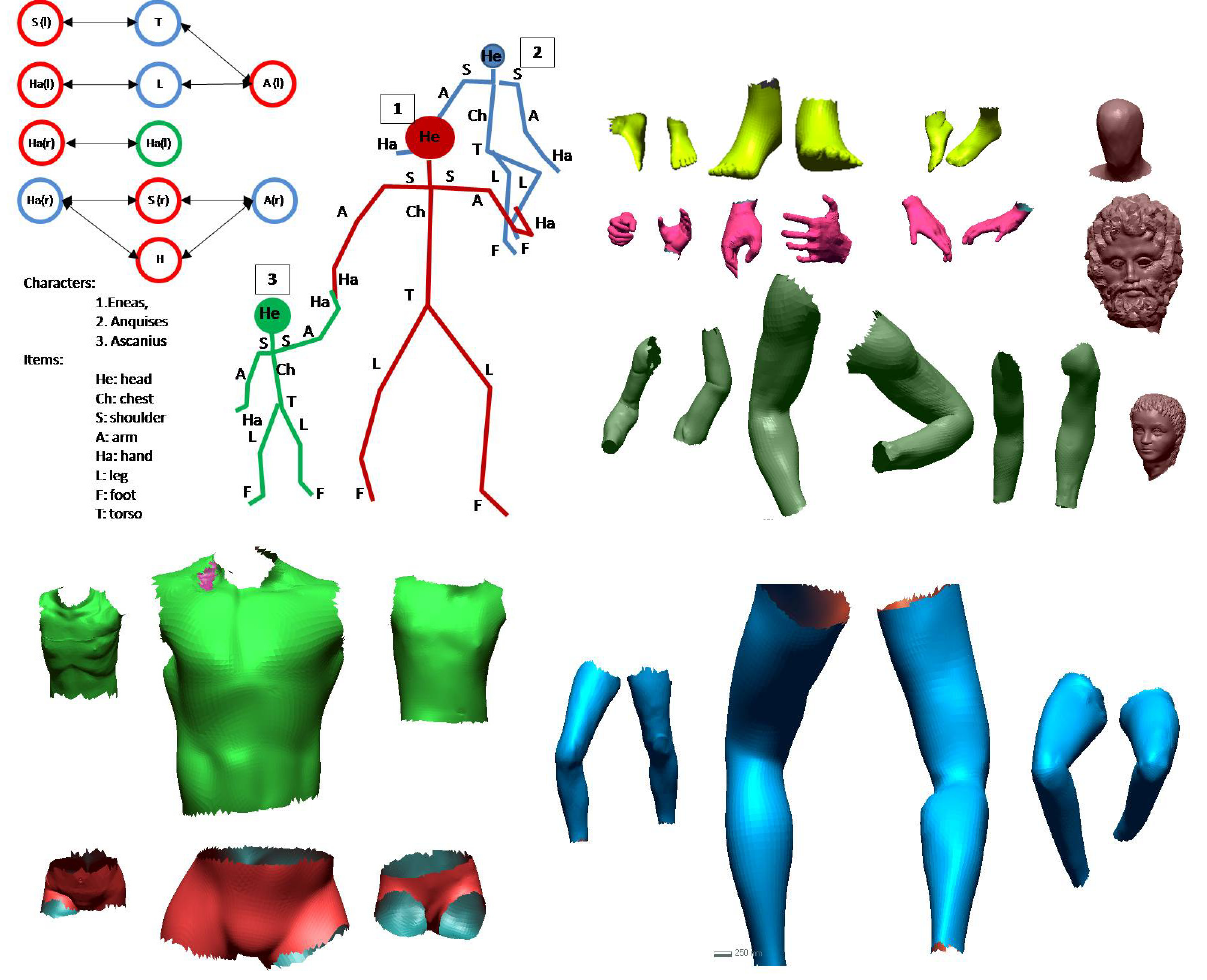
Figure 13. ( a ) Elemental structure of the model proposed including essential parts of the body and the relationship graph. ( b ) Models of some parts of the characters scaled to real